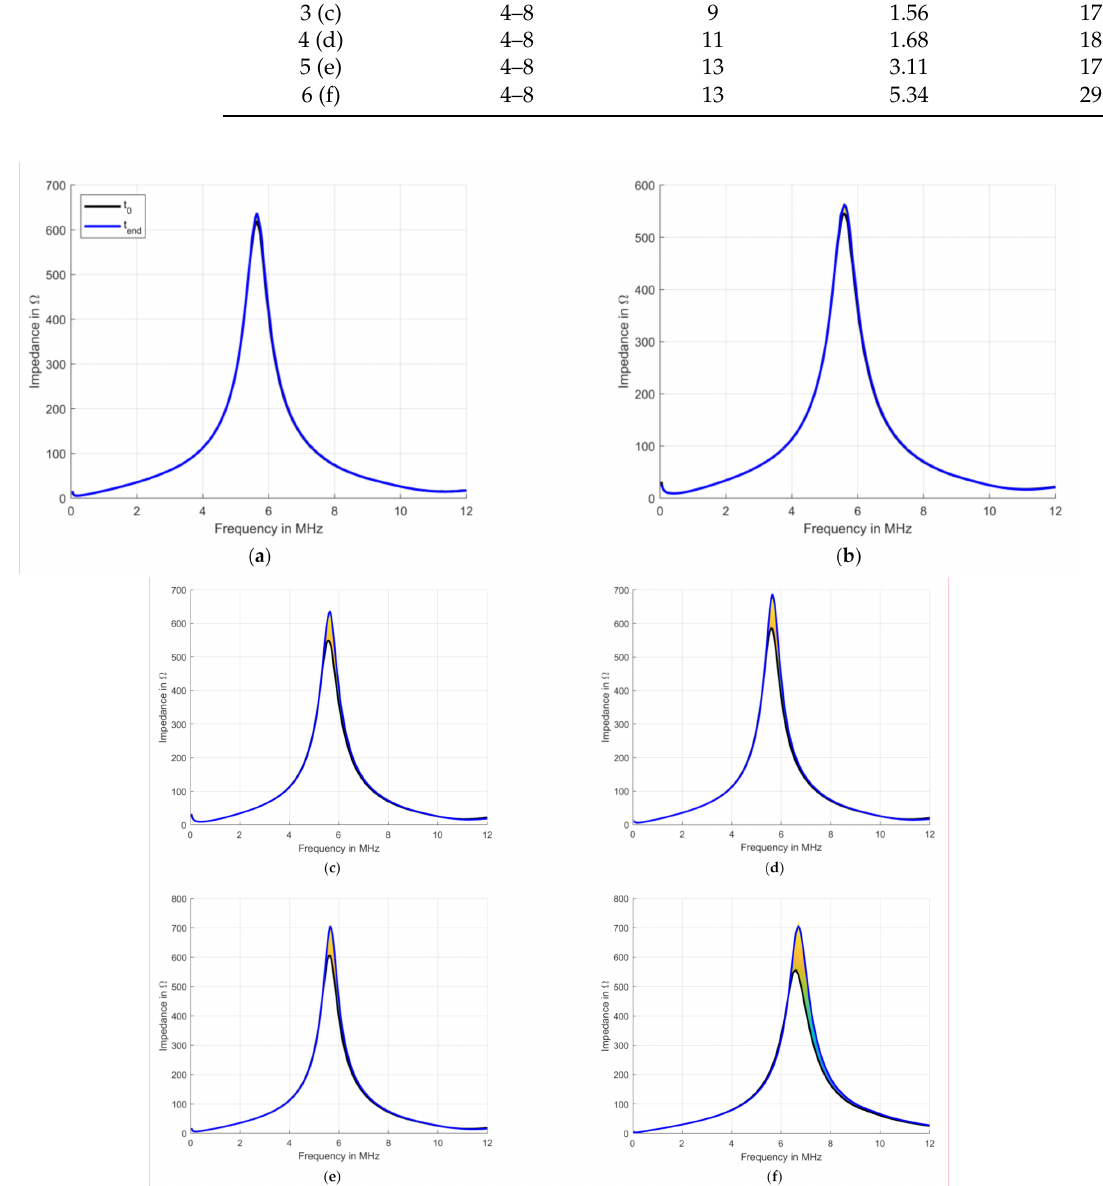
Figure 10. Impedance spectrum over time during down-top water flow corresponding to the measurements 1–6 ( a – f